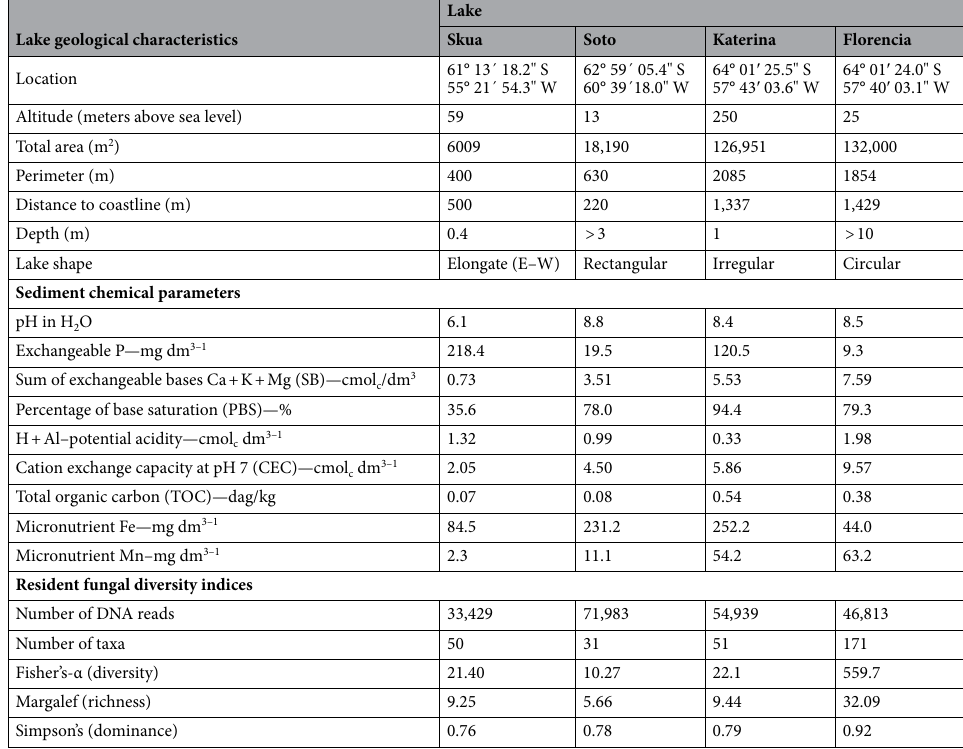
Table 1. Lake locations, characteristics, sediment physicochemical data and diversity indices of fungal assemblages obtained from Skua Lake (Elephant Island), Soto Lake (Deception Island), Katerina Lake and Florencia Lake (James Ross